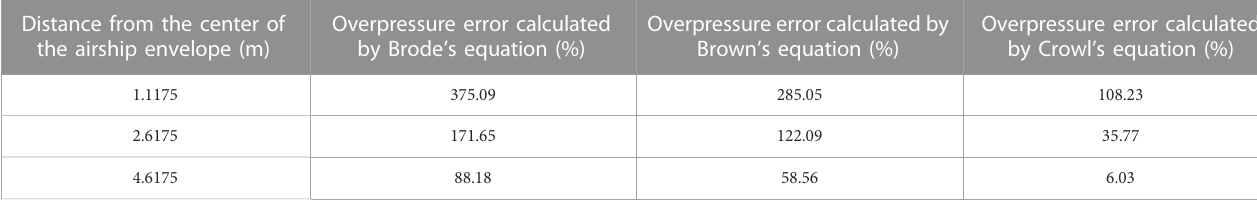
Test overpressure (Pa)